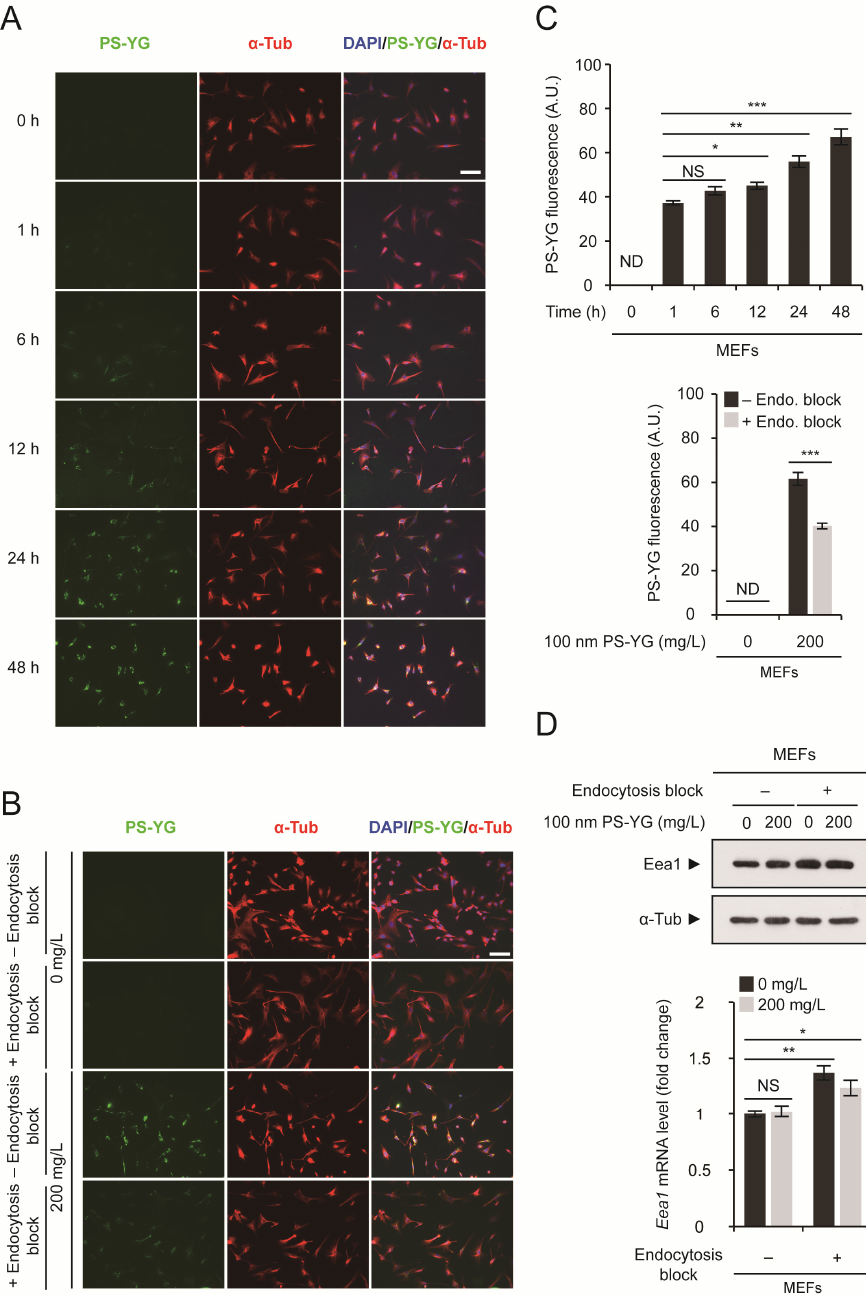
Figure 1. Polystyrene (PS) nanoplastic uptake via endocytosis. ( A ) Mouse embryonic fibroblasts (MEFs) were treated with 100 nm PS-YG (yellow-green) nanoplastics at 200 mg/L for 0 to 48 h. Cells were subjected to immunofluorescence analysis using an anti- α -tubulin ( α -Tub) antibody and DNA was visualized with DAPI. Direct fluorescence from PS-YG nanoplastics was also visualized. ( B ) Endocytosis was blocked using sodium azide. MEFs were pretreated with sodium azide (+ Endocytosis block) or vehicle ( − Endocytosis block) for 16 h before 100 nm PS-YG treatment. After 16 h, MEFs were treated with 100 nm PS-YG nanoplastics at the indicated concentration for 24 h. ( C ) Quantitative analysis of PS-YG fluorescence levels in ( A , upper panel) and ( B , lower panel). Green fluorescence levels in all α -Tub-positive cells in the field were determined and expressed as the means ± SEM from the number of cells shown. ( D ) Immunoblot detection (upper panel) and qRT-PCR analysis (lower panel) of Eea1 in MEFs treated with PS-YG at the indicated concentration for 1 day with or without sodium azide pretreatment to block endocytosis. α -Tubulin ( α -Tub) was used as a loading control for immunoblot analysis. mRNA expression levels of Eea1 were determined by qRT-PCR ( n = 3 each), normalized against Gapdh levels and expressed as the fold change relative to untreated control levels. Representative images of cells or immunoblots are shown. qRT-PCR data are expressed as the means ± SEM from the indicated number of samples. * p < 0.05; ** p < 0.01; *** p < 0.001 between two groups, as indicated by horizontal bars. ND, not determined. NS, not significant. Scale bar, 100 µ